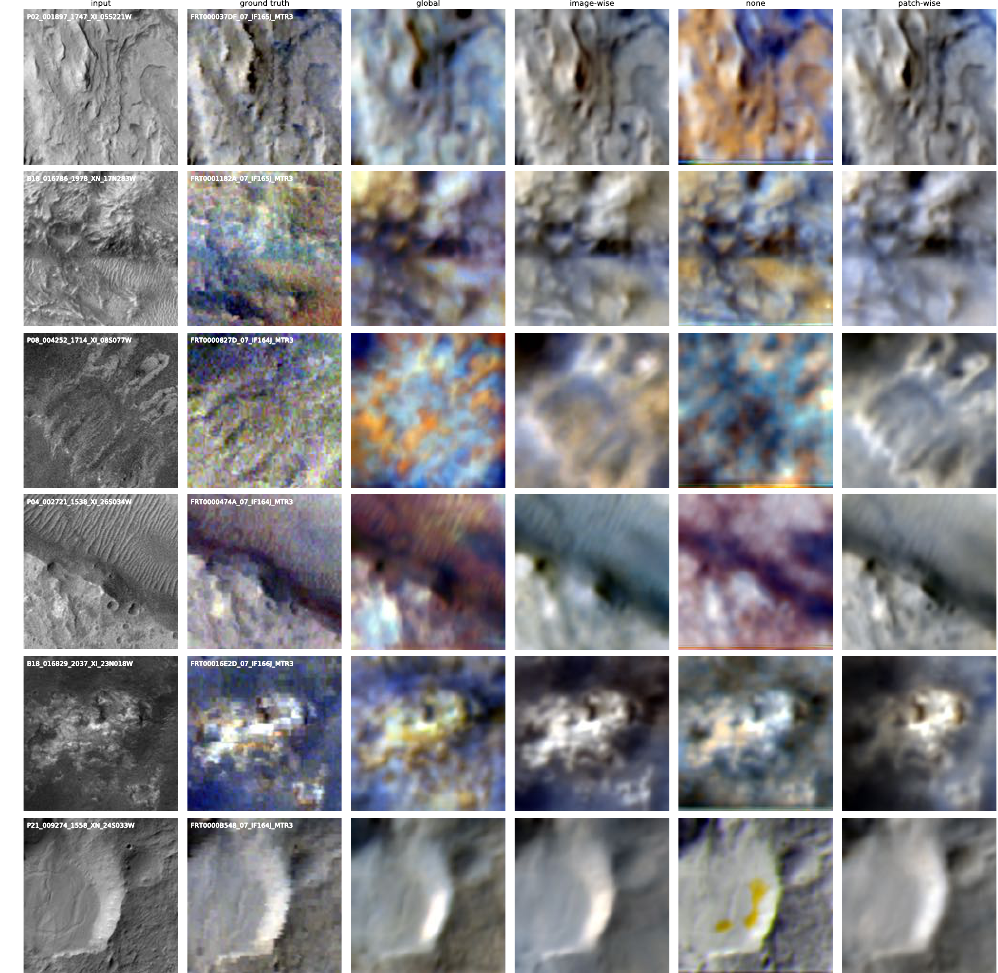
Figure 12. Appearance comparison of six EVC test patches across different normalization methods. Without normalization, not much colorization or processing is applied to the input image and some patches produce widely spanning artifacts. Global normalization yields much more plausibly colored results, but some patches stand out again as being miscolored. Both these results indicate an unstable training process and a non-robust model, which drastically changes its output if the input shows a slightly different region. With patch-wise normalization, each individual output appears plausible, but it is not directly possible to reassemble the image. With each patch occupying a similar range of values, discontinuities are strongly apparent, as would be the case when putting together ground-truth patches. In this predicted reassembly, some patches appear desaturated and gray, while others exhibit a broad range of colors that are not fitting with those given areas. Compared to this, an image-wise normalization allows the creation of a coherent overall image, since ground- truth patches now form a continuum across each image. The more favorable distribution of pixel values compared to global normalization also improved the robustness of the network, hence why this method was chosen for further